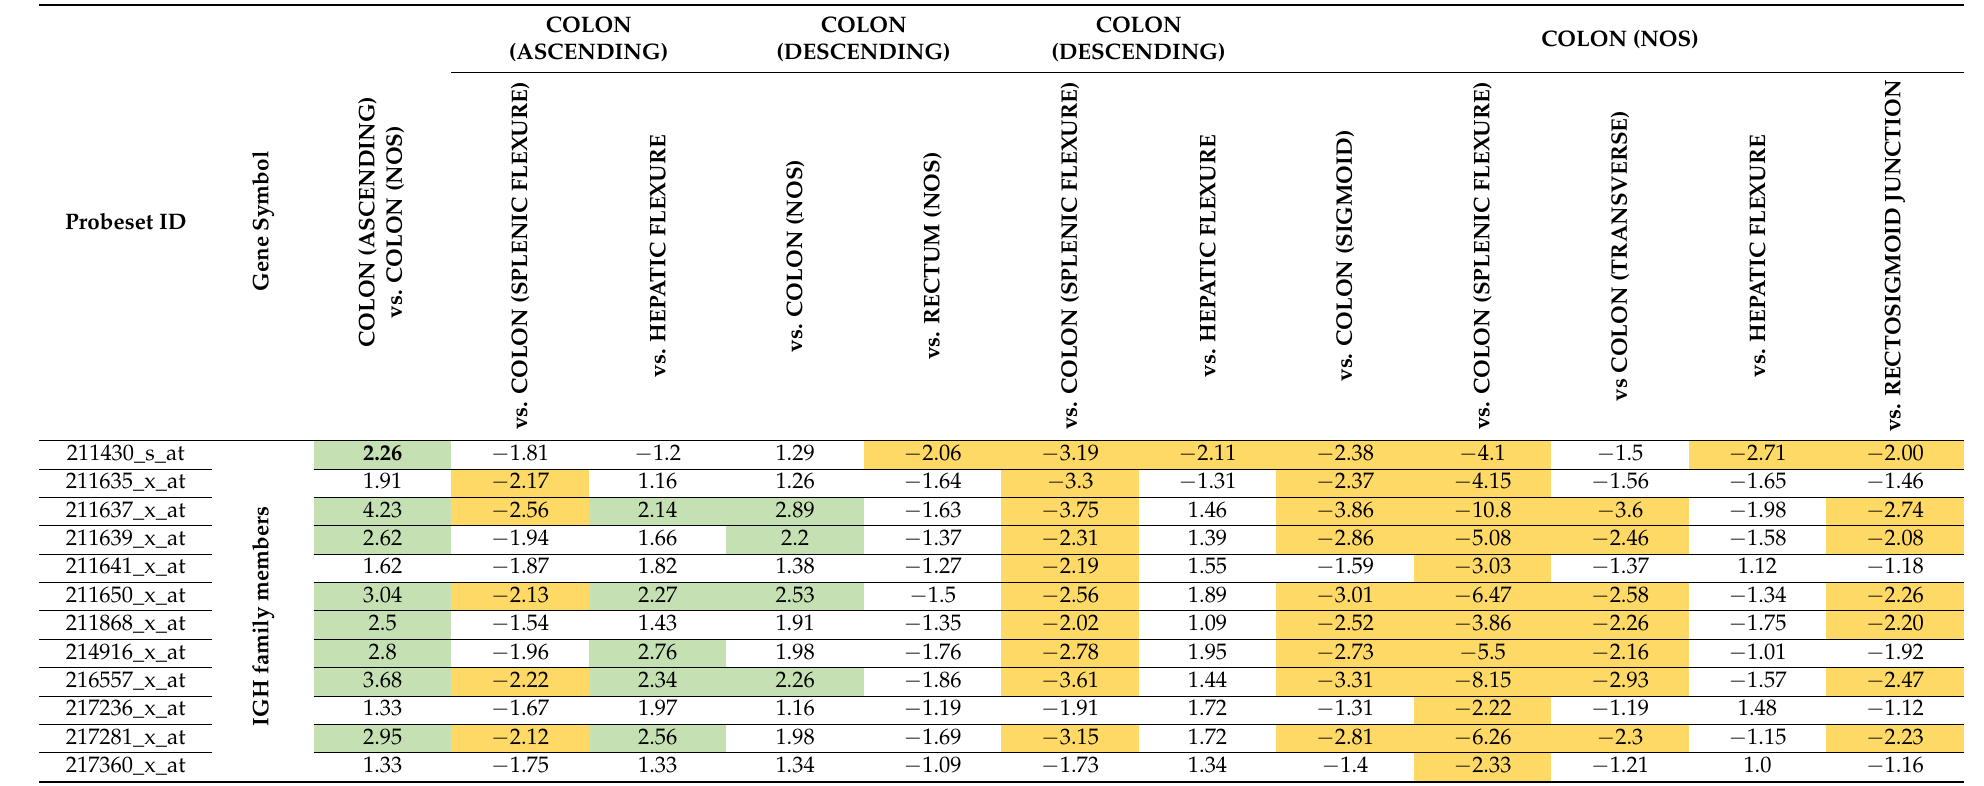
Table 7. Fold change in antigen transcript levels that achieved significance, when comparing collection sites (colon ascending, descending and nos). Light green cells indicate values that are increased by greater than 2-fold, yellow cells indicate values that are decreased by greater than